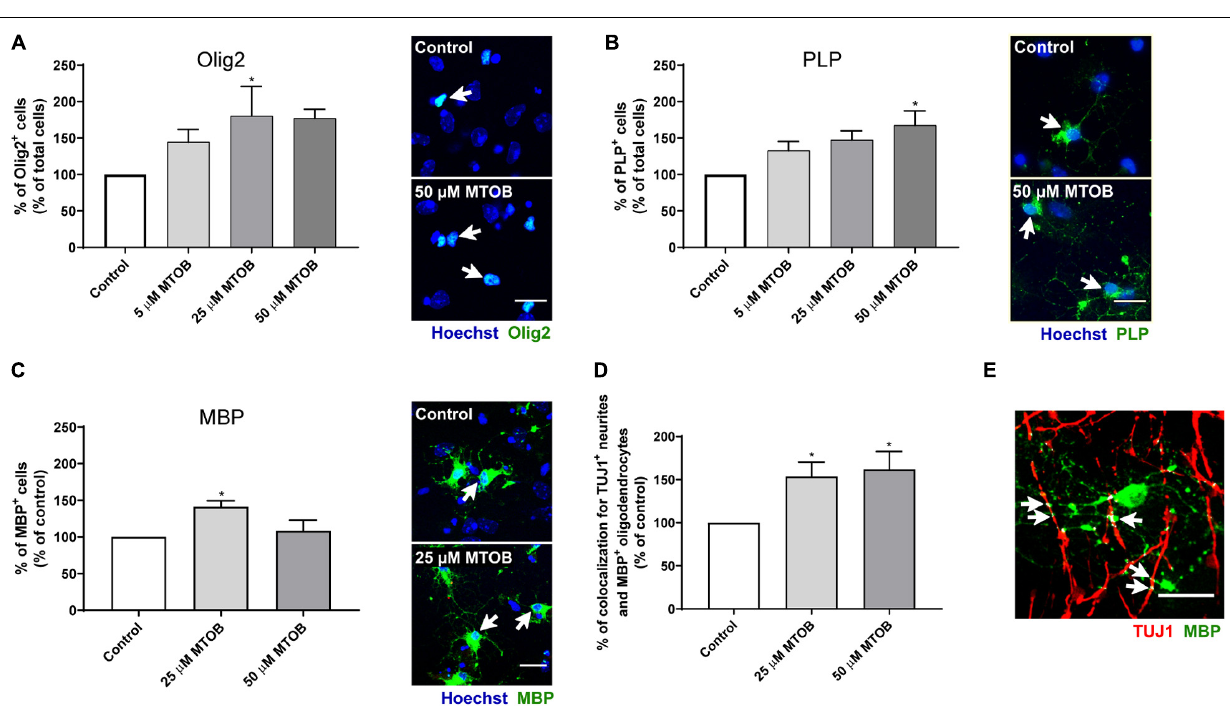
FIGURE 7 | CtBP modulation induces the differentiation of progenitor cells into oligodendrocytes and enhances neurites myelination by mature oligodendrocytes. (A–C) Bar graphs depict the percentage of (A) Olig2-immunostained oligodendrocytes, (B) PLP-immunostained mature oligodendrocytes, and (C) MBP-immunostained mature oligodendrocytes, maintained in culture for 7 days after MTOB treatments. Data are expressed as a percentage of control ± SEM. (A) n = 3–4, (B) n = 4, and (C) n = 3–4 independent experiments. Control was set to 100%. * p < 0.05 when compared with control, using one-way ANOVA, followed by Dunnett’s multiple comparison test. Representative confocal images of Olig2, PLP and MBP immunostainings are shown next to the graph, with white arrows highlighting staining. Nuclei are stained with Hoechst. Scale bar: 20 µ m. (D) Bar graph depicts the percentage of TUJ1 + -neurites that were ensheathed by myelin sheets of MBP-mature oligodendrocytes. Data are expressed as a percentage of control ± SEM. n = 3–4 independent experiments. Control was set to 100%. (E) Representative confocal image of the visualization of myelin sheaths that enwrap neurites, with white arrows highlighting the overlay regions. Scale bar: 20 µ